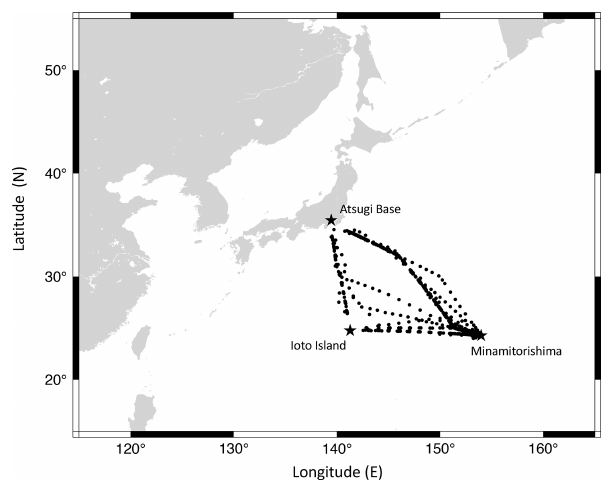
Figure 1. Locations of C-130 aircraft air sampling for the period May 2012–March 2020 (circles). Locations of Minamitorishima (MNM), Ioto Island and Atsugi Base are also shown by stars. Lati- tudinal and vertical distributions are taken during the level flight and descent portion at MNM, respectively. In total, 2206 of air samples were collected, and 1783 of them were analyzed for O 2 / N 2 and Ar / N 2 ratios, as well as the stable isotopic ratios of N 2 , O 2 and